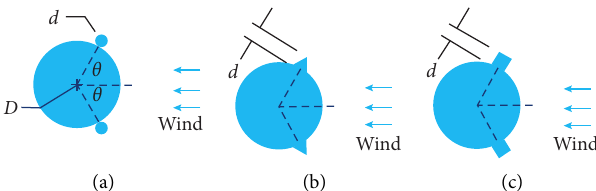
Figure 5: Cross-sectional shapes of control rods. (a) Circular. (b) Triangular. (c) Square